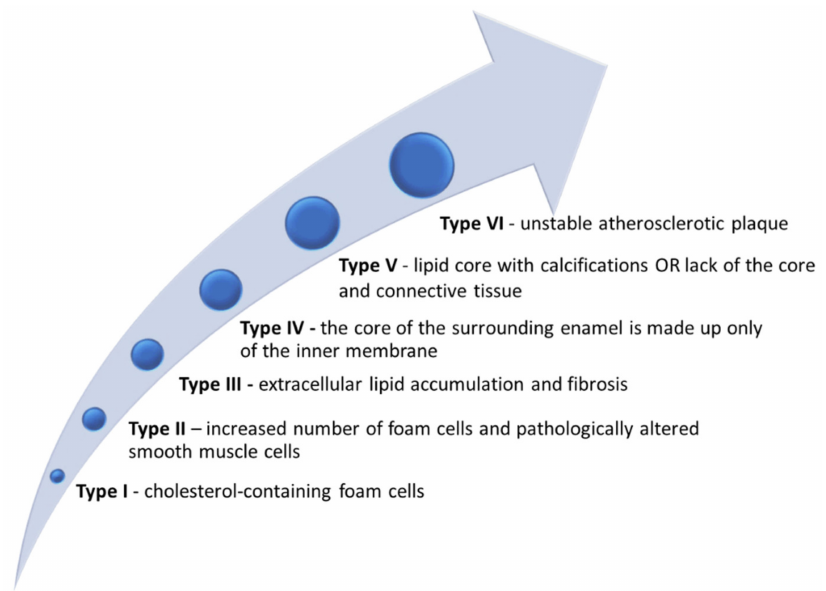
Figure 2. Atherosclerotic lesions: histopathological classification, role of lipid accumulation, involved cells, and matrix components in the progression of the atherosclerotic